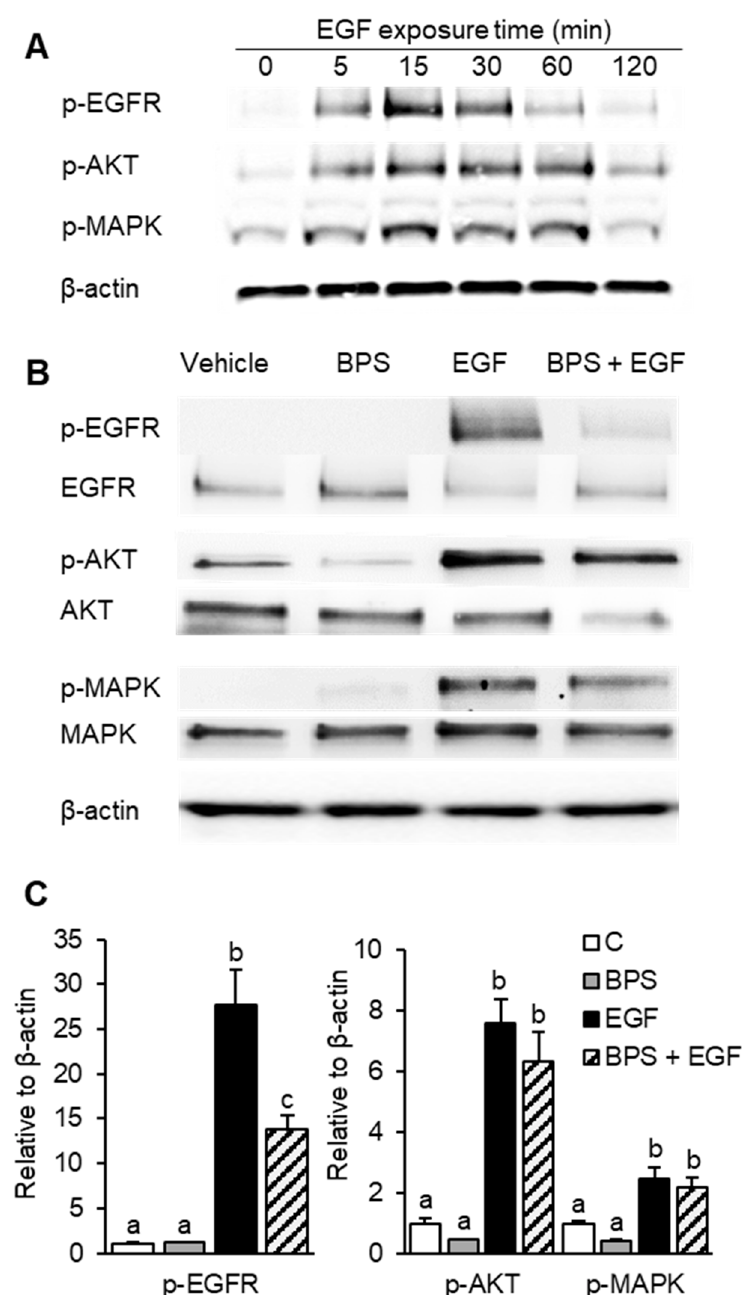
Figure 1. Effect of BPS exposure on EGF-mediated EGFR pathway activation in HTR-8/SVneo cells. ( A ) Representative Western blot images for total and phosphorylated proteins and the reference protein β -actin upon exposure to 30 ng/mL of EGF over time. ( B ) Representative Western blot images and ( C ) quantification (mean ± SEM) of total and phosphorylated EGFR, AKT and MAPK, and β -actin upon exposure to 0.1% DMSO (control; C), BPS (1000 ng/mL; graybars), EGF (30 ng/mL; closed bars), or BPS + EGF (stripped bars) treatments. A generalized linear model was used to statistically compare treatments. Different letters denote statistical differences among treatment groups at p < 0.05 ( n = 3 technical replicates/group). BPS: bisphenol S, EGF: epidermal growth factor, p-EGFR: phospho-EGF receptor, p-AKT: phospho-protein kinase B, and p-ERK: phospho-extracellular receptor kinase.